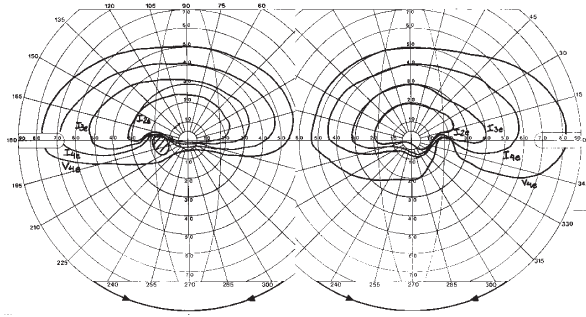
Figure 2 - Goldmann visual field showing severe inferior visual field defect in both